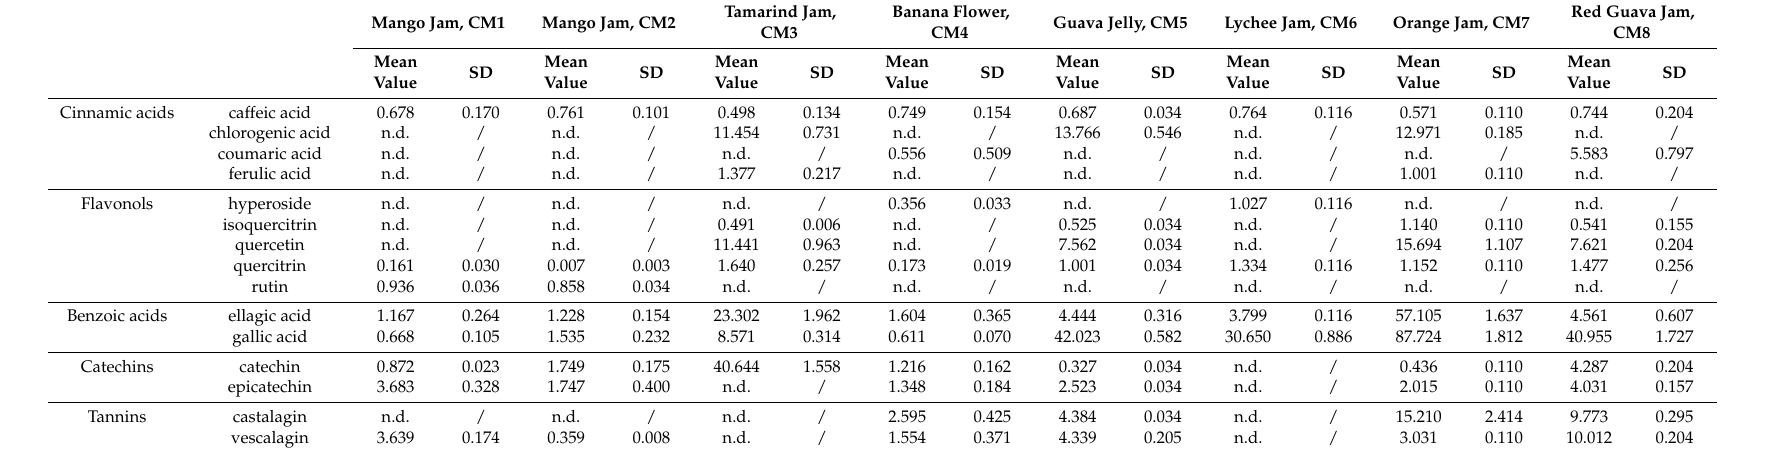
Table 2. Phytochemical fingerprint of the polyphenolic compounds in analysed jams and jellies. Tamarind Jam, Mango Jam, CM1 Mango Jam, CM2 CM3